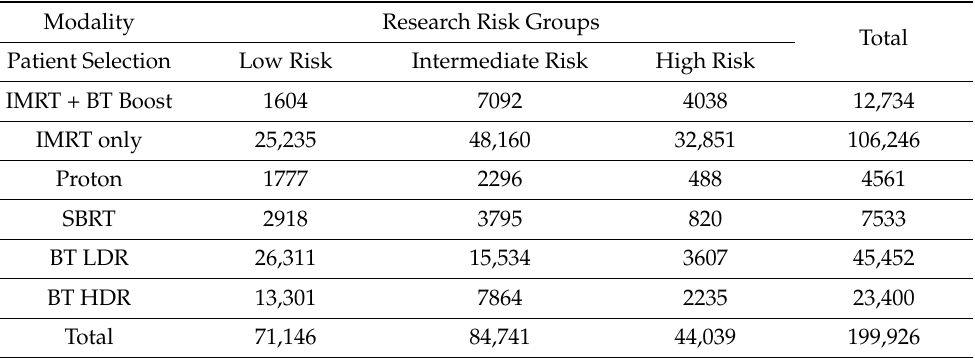
Table 1. Stratification of studied PCa population in NCDB Database (2004–2015) by research risk groups and treatment modality.